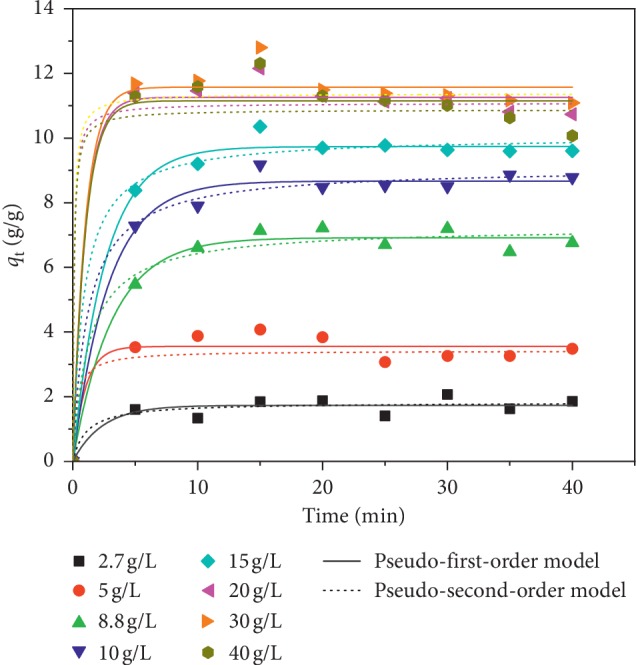
Sorption kinetics of oil onto PO milled fibers for different initial concentration of crude (biosorbent dose = 0.05 g; solid lines and dotted lines represent the fitting curves with pseudo-first-order and pseudo-second-order models, respectively).